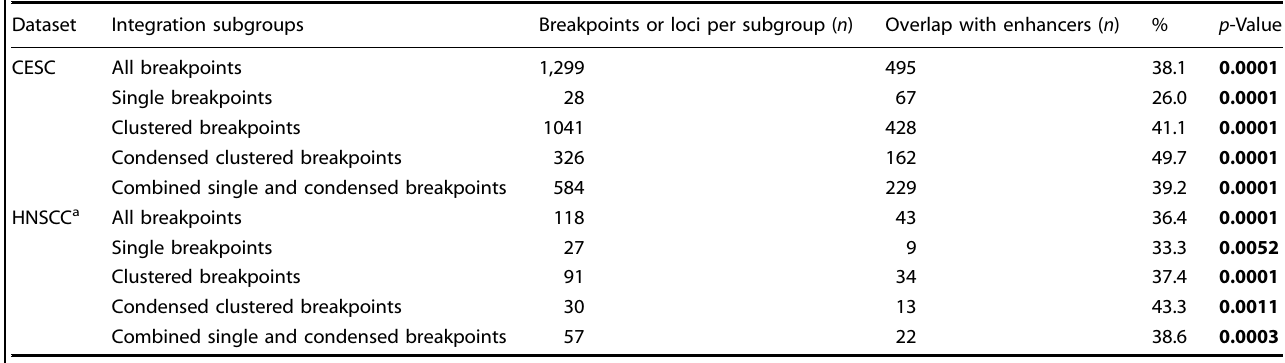
Table 2. Overlap of integration breakpoints with keratinocyte-speci fi c enhancers.